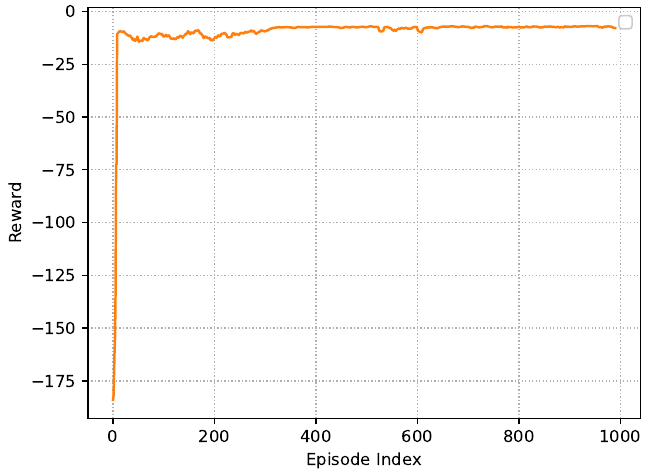
Figure 3. Learning curve in the training